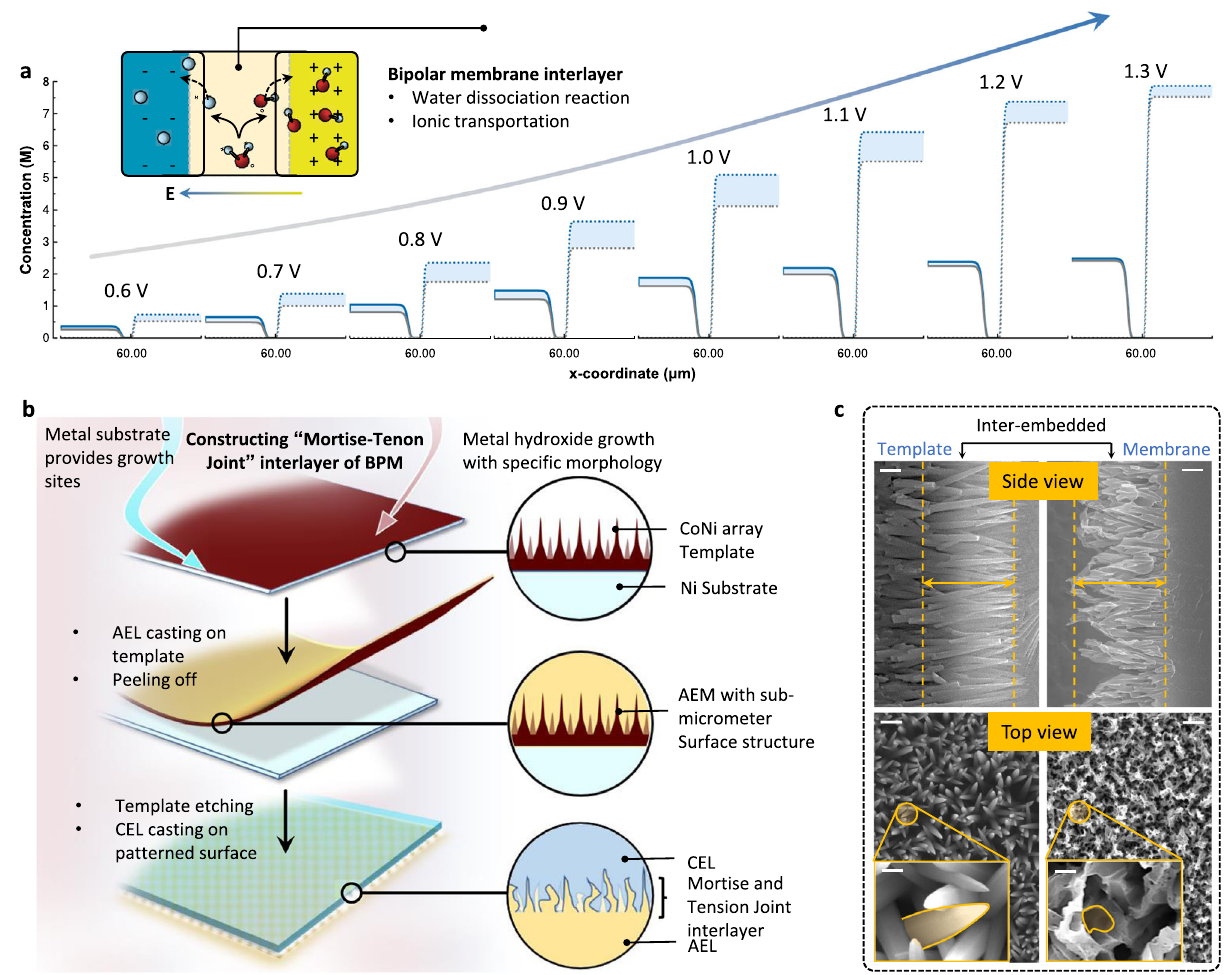
Fig. 2 | Design philosophy ofBM and illustrationofMBMarchitectureprocess. a Concentrationpro fi leofH + (solid)andOH − (dot)neartheinterfaceofAELandCEL with applied transmembrane voltage from 0.6 to 1.3V based on numerical simu- lation via COMSOL software. The disparity of BM with (blue line) and without (black) enhanced interfacial kinetics is presented as a wathet lump. The x-coordinateoftheinterfaceissetto x =60 μ manda20nmregionofbothlayersis